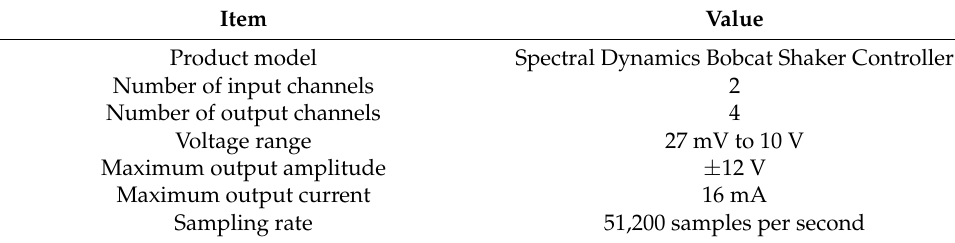
Table 3. Specifications of the Bobcat spectrum